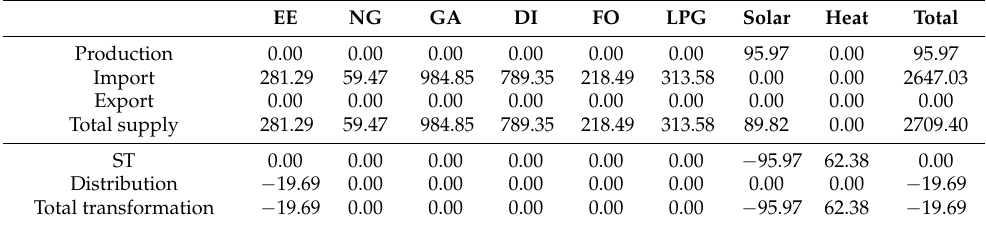
Figure 8. Scenario 2. Energy consumption in 2030, residential sector.